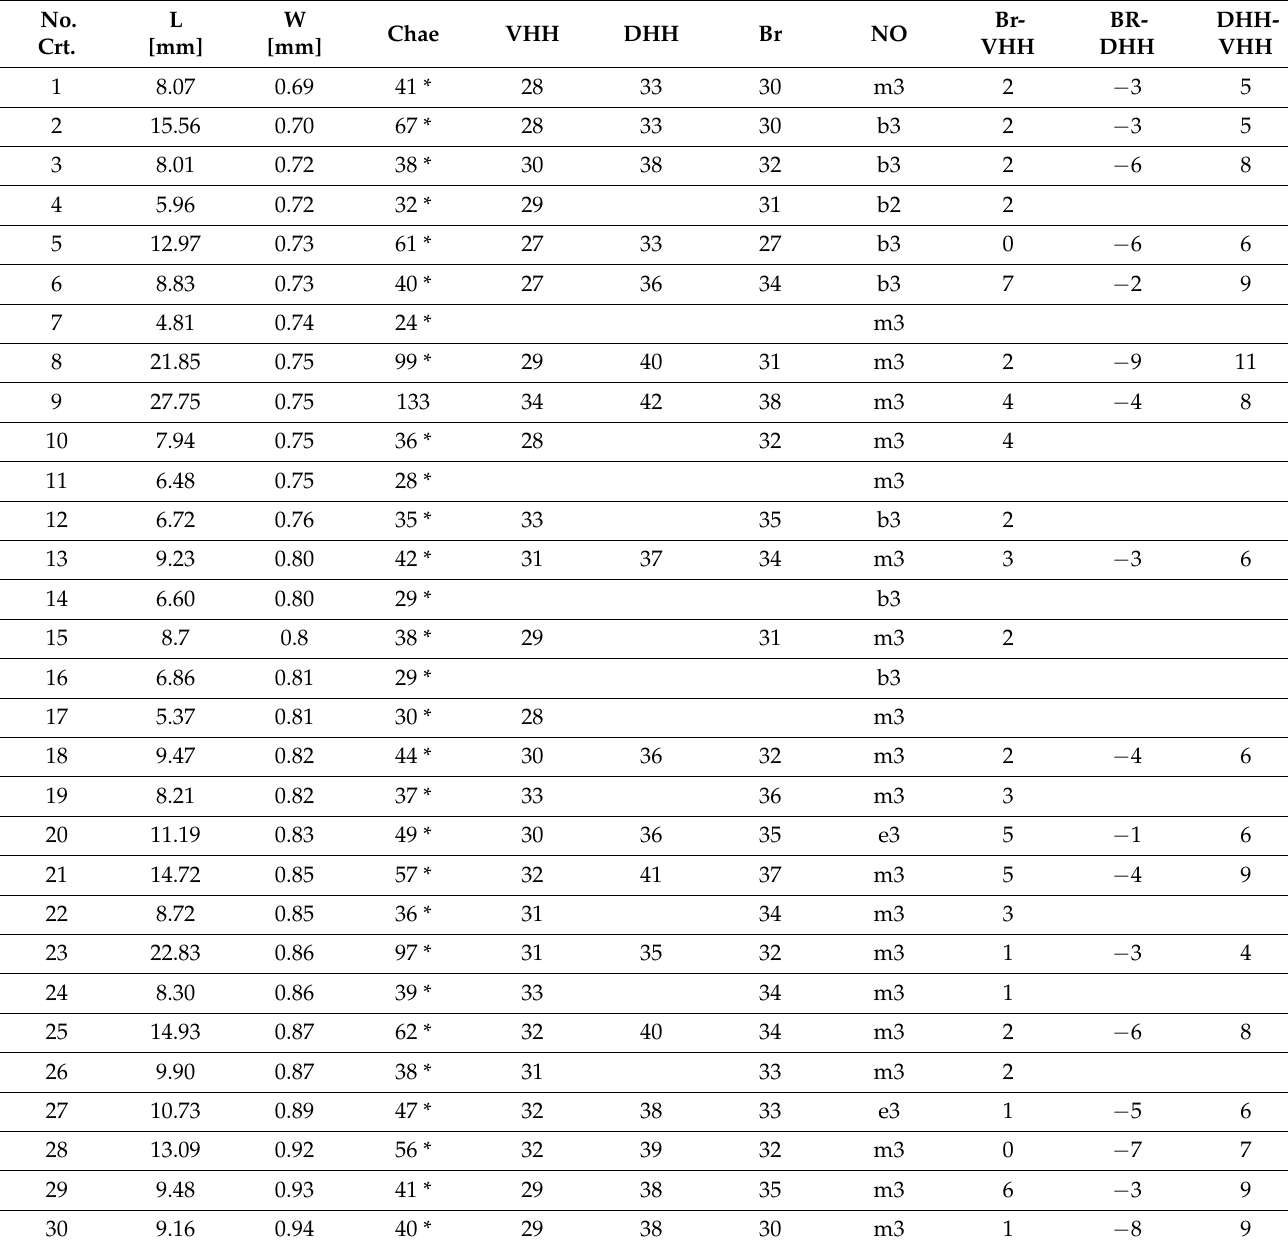
Table 1. Variability of morphometric characters for different sizes of M. neglecta (L—length, W— width, Chae—number of chaetigers, * incomplete